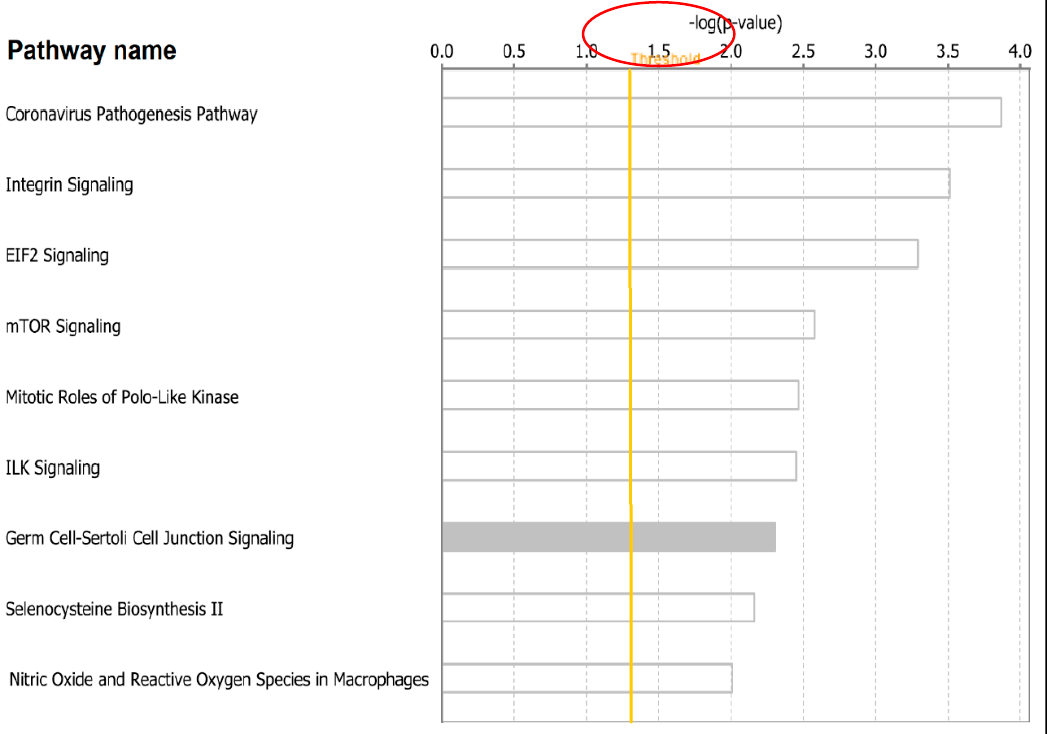
Figure 5. Signaling pathways associated with both COVID-19 and lung cancer represented as bars. The orange solid line indicates the threshold above which a signaling pathway was declared significantly associated with both diseases, as determined by the –log( p -values) shown on the x-axis above. The y-axis shows names of signaling pathways associated with both diseases.